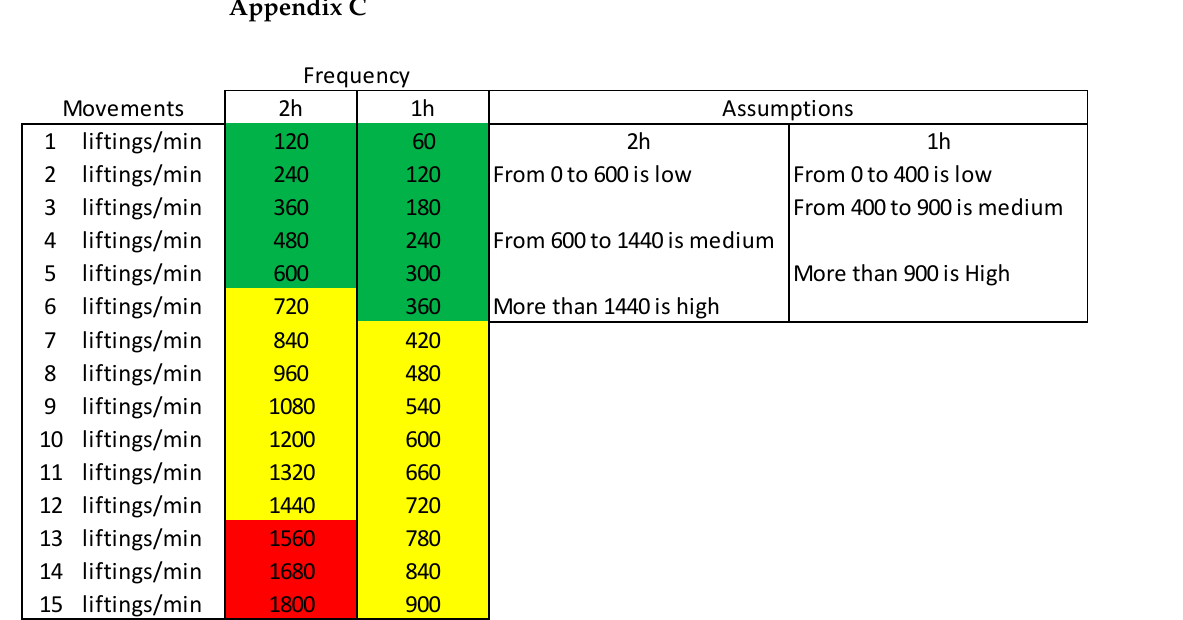
Figure A1. General assumptions for frequency for Tables 3 and 7. The color green represents low risk, the color yellow represents medium risk and the color red represents high risk.